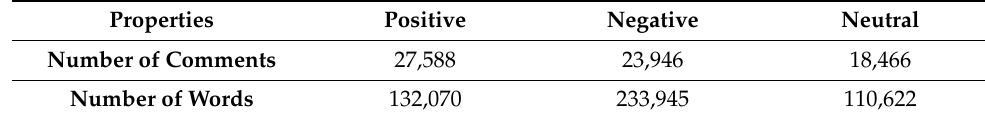
Table 4. Description of Emirati Sentiment Analysis Dataset (ESAAD).